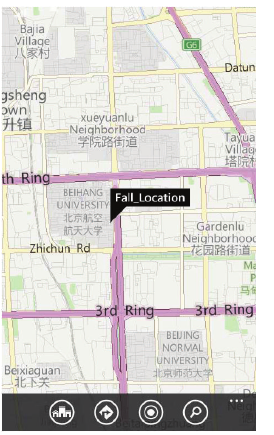
Figure 13: Fall location displayed on a Web